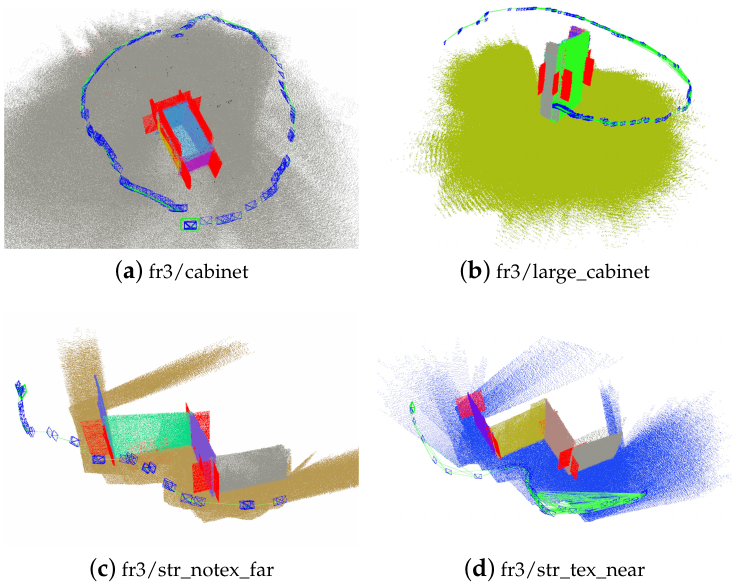
Figure 10. Supposed planes generated in the tracking process. Red planes denote supposed planes.